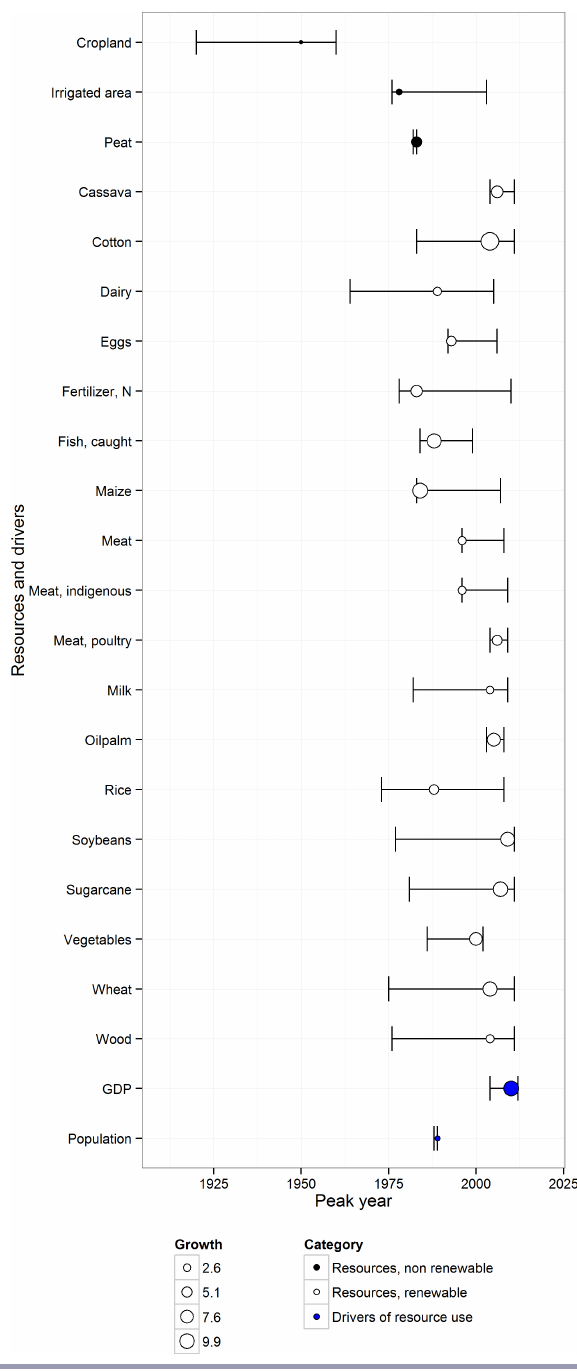
Erratum: In the original publication of Figure 3 the data for milk and wood were erroneous. A correction was made on 24 February